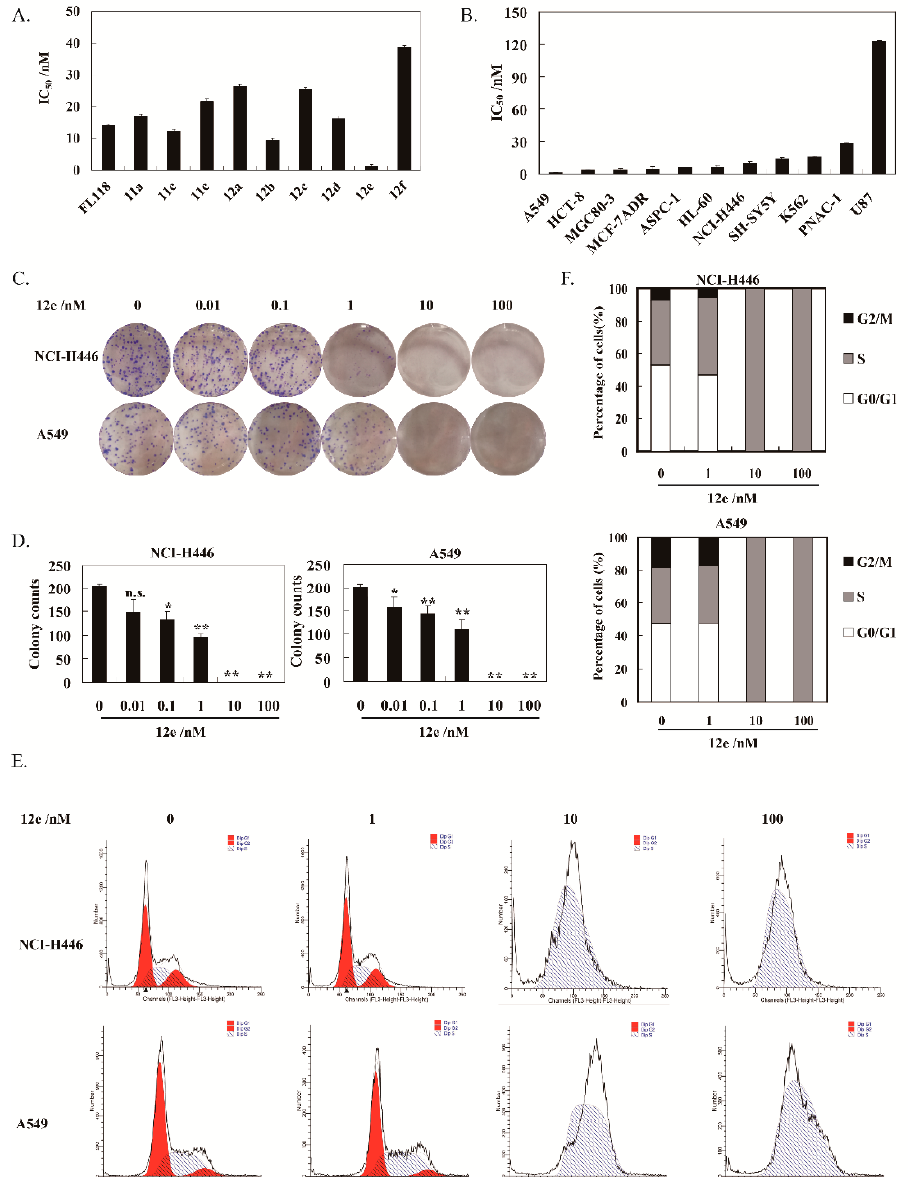
Figure 2. 12e inhibits lung cancer cell growth. ( A ) A549 cells were treated with various concentrations of synthesized compounds for 72 h. Cell proliferation was determined using SRB assay. ( B ) Various cancer cells were treated with indicated concentrations of 12e for 72 h. Cell proliferation was determined using SRB assay. The data are presented as means ± SD from three independent experiments. ( C ) 12e inhibits the colony formation. Cells were treated with 12e (0.01–100 nM) for 14 days, and stained with Giemsa. Then colonies were photographed and counted. ( D ) Quantification of the number of colonies. Colonies consisting of ≥ 50 cells were scored. Data are presented as means ± SD from three independent experiments. * p < 0.05, ** p < 0.01 vs. control. ( E ) 12e affected cell cycle distribution. Cells were treated with 12e (0.01-100 nM) for 24 h, then were collected, and stained by PI. The DNA content of cells was determined with the MoFlo XDP flow cytometry system. ( F ) Histograms show the percentage of cells in G 0 /G 1 , G 2 /M, and S phase after treatment with 12e.